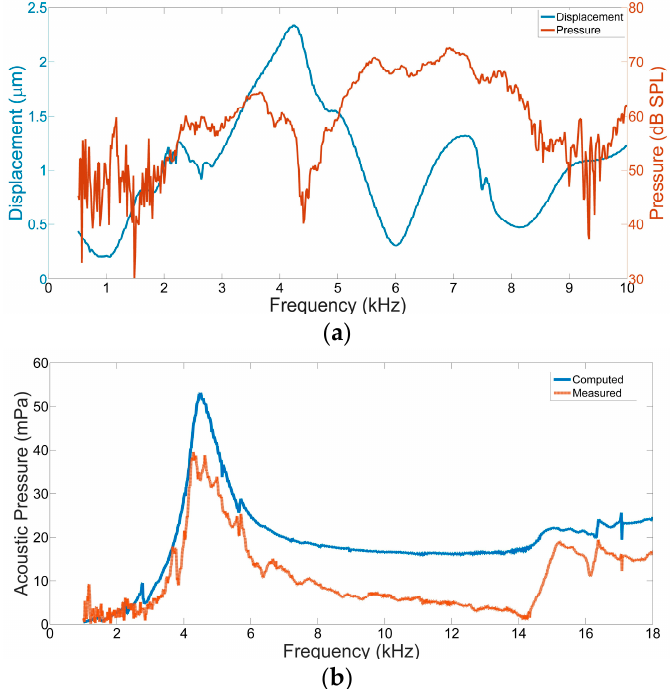
Figure 3. The figure ( a ) shows the experimental mode shape of the structure as observed using Polytec Laser Doppler Vibrometer, MSA-500, ( b ) shows plot of the displacement response (center point on the diaphragm) from a single MEMS device actuated at diaphragm’s natural frequency.